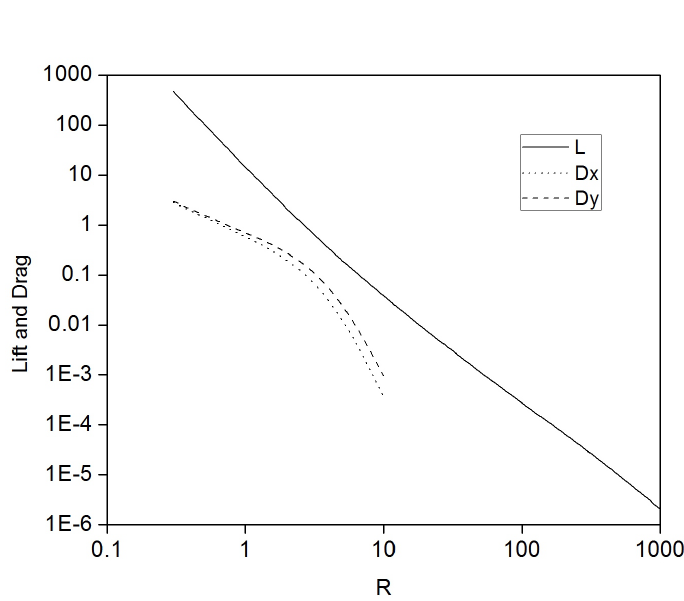
Fig. 6 Normalized lift and drag as a function of Reynolds number.